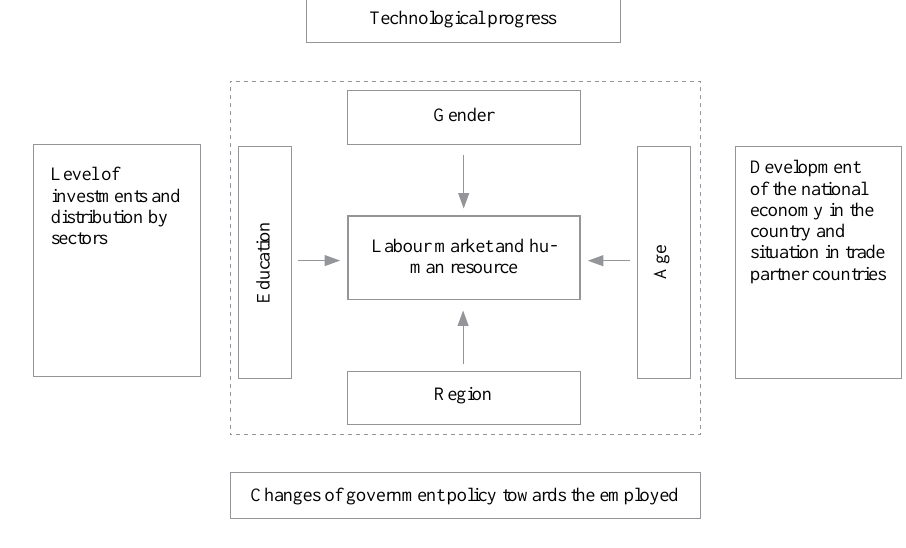
Fig. 2. Factors influencing the labour force demand